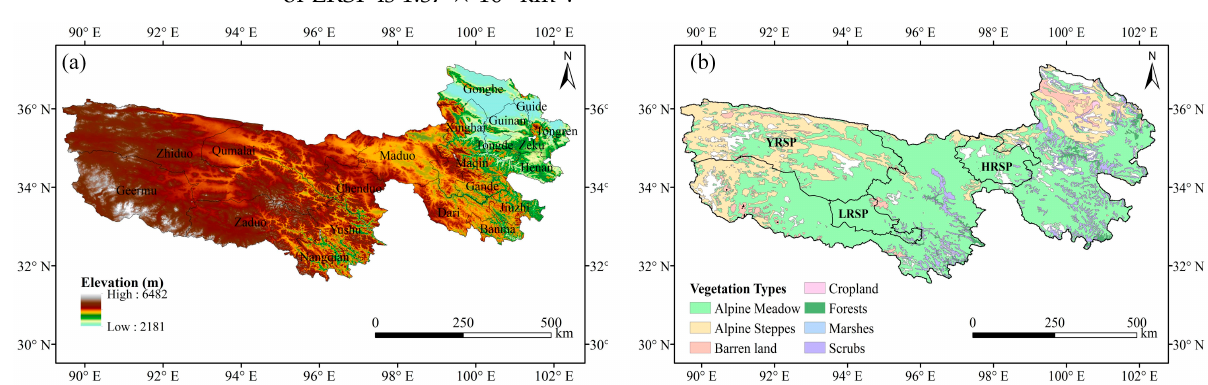
Figure 1. Spatial distribution of elevation ( a ) and vegetation types ( b ) in the TRSR and its subregions.